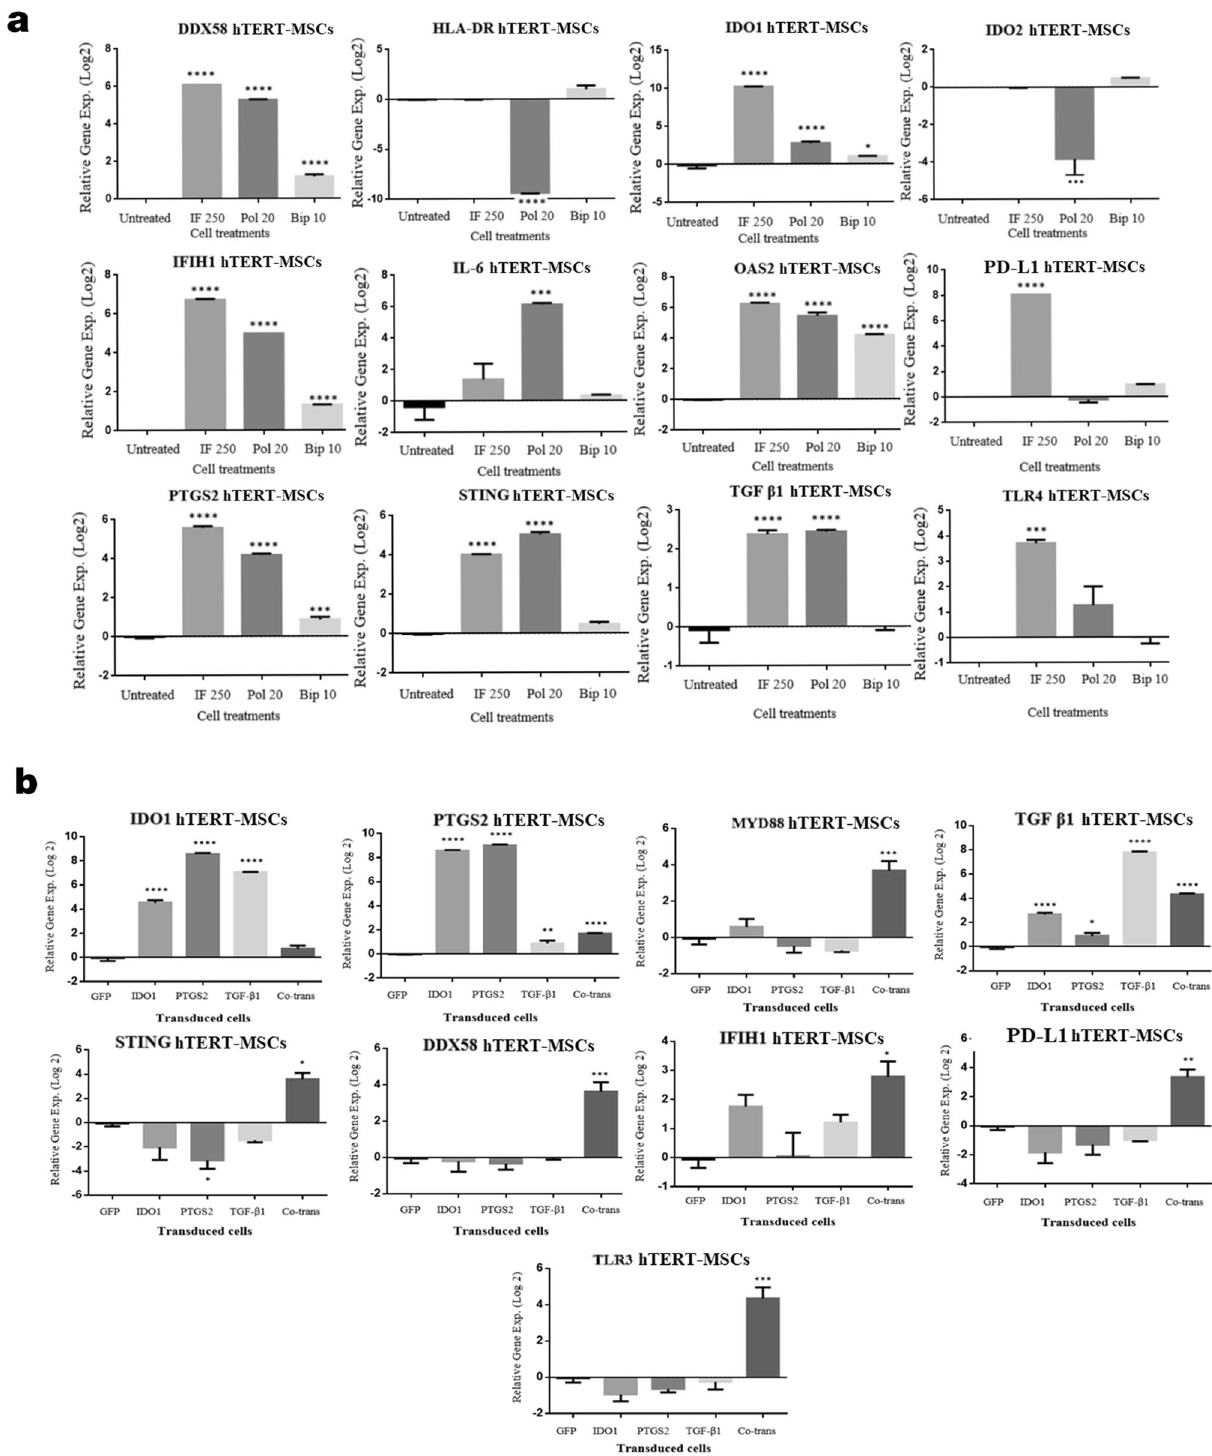
Figure 5. Gene expression analysis. ( a ) Gene expression analysis (mean of independent experiments ± SEM) for hTERT-MSCs following treatment with IFN-γ (250 U/ml, 48 h), poly(I:C) (20 µg/ml, 48 h) and BiP (10 µg/ ml, 72 h) in comparison to untreated cells using qRT-PCR analysis. ( b ) Gene expression analysis (mean of independent experiments ± SEM) of the hTERT-MSCs bearing different gene constructs in comparison to GFP transduced cells via qRT-PCR analysis. Among different candidate immune encountered genes, genes depicting statistically significant differences (significance level p < 0.05) after modification in comparison to untreated cells/GFP transduced cells are demonstrated. Data analysis was performed by CFX Manager Software (version 1.6) and GraphPad Prism, version 6.00. * p < 0.05, ** p < 0.01, *** p < 0.001 and **** p <